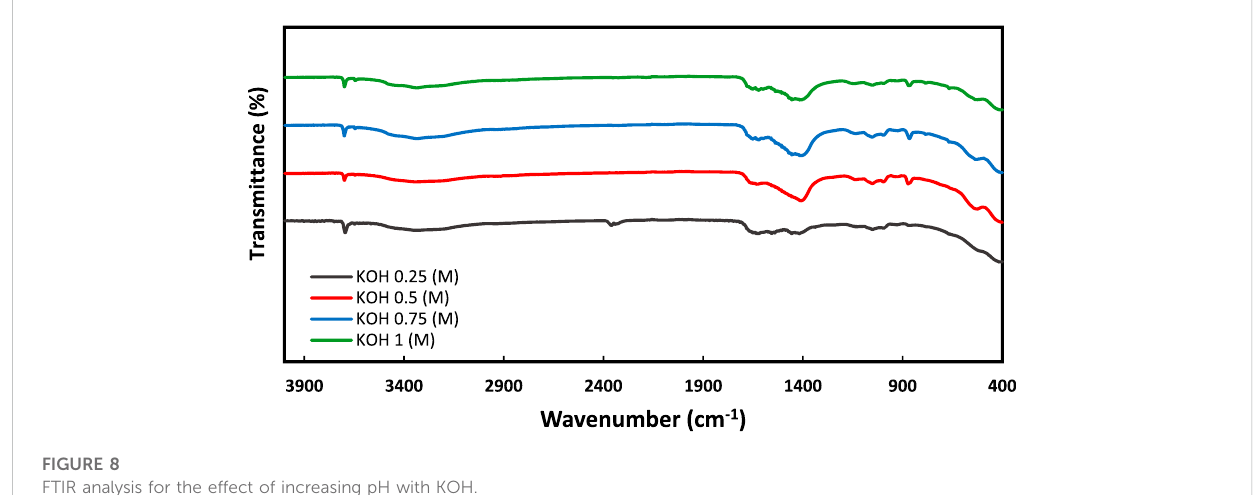
FTIR analysis for the effect of increasing pH with KOH.